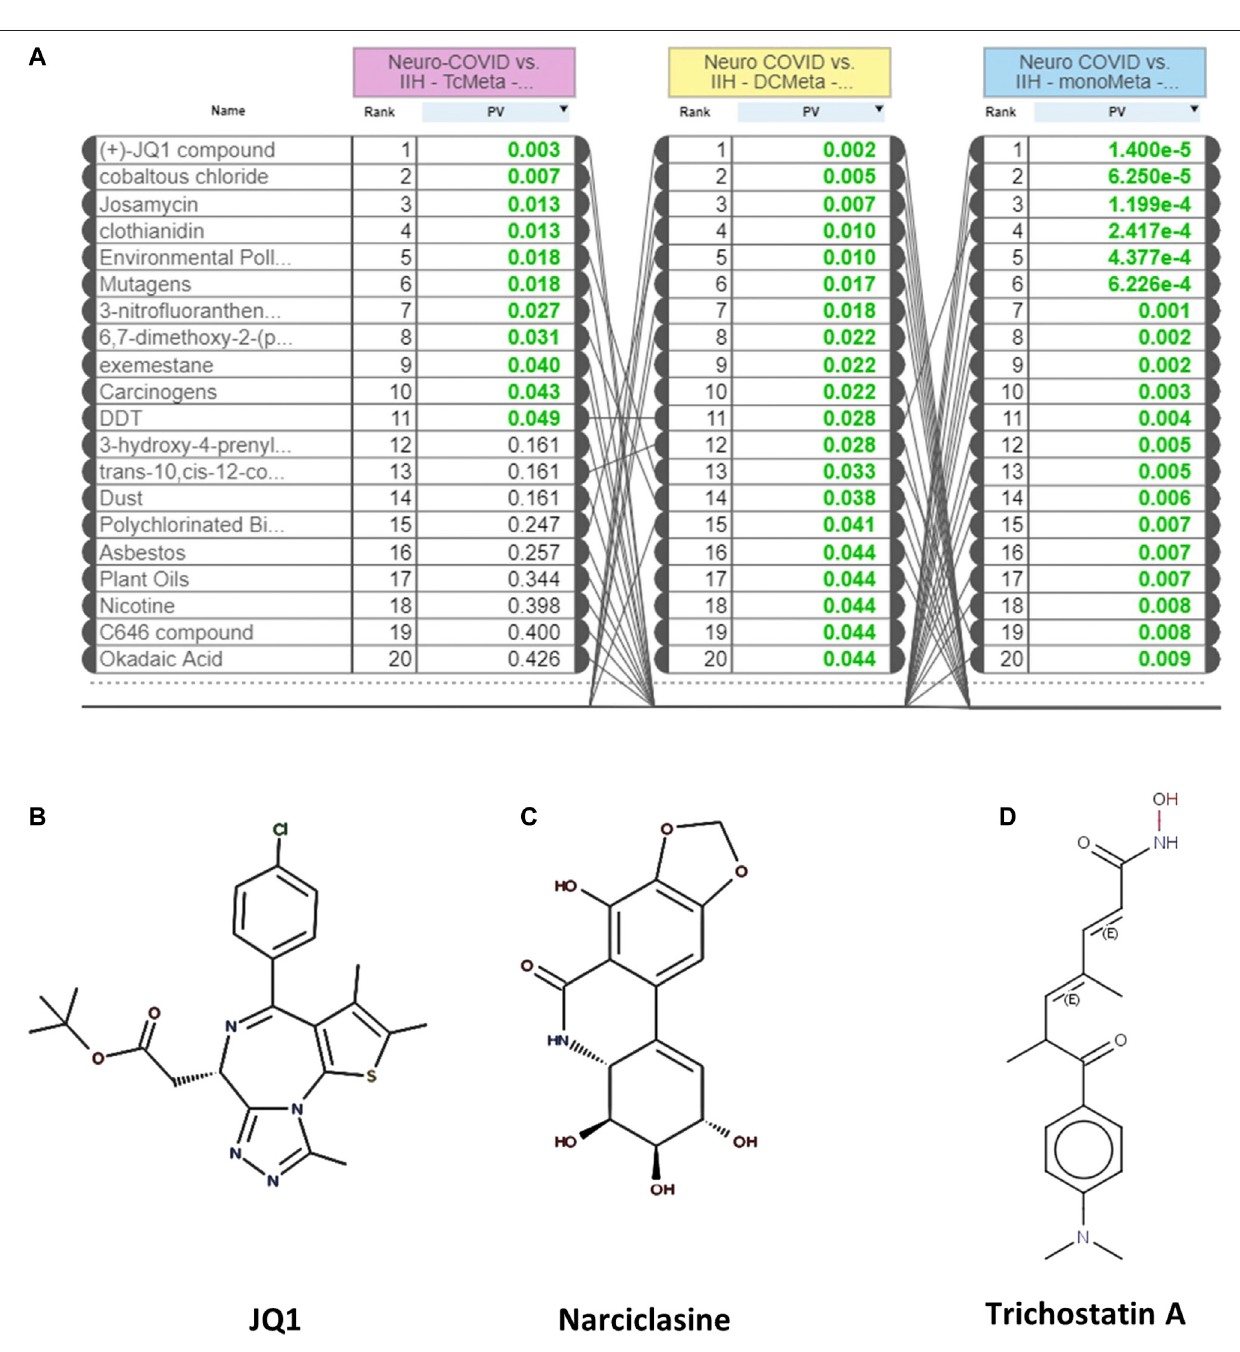
Frontiers in Pharmacology |